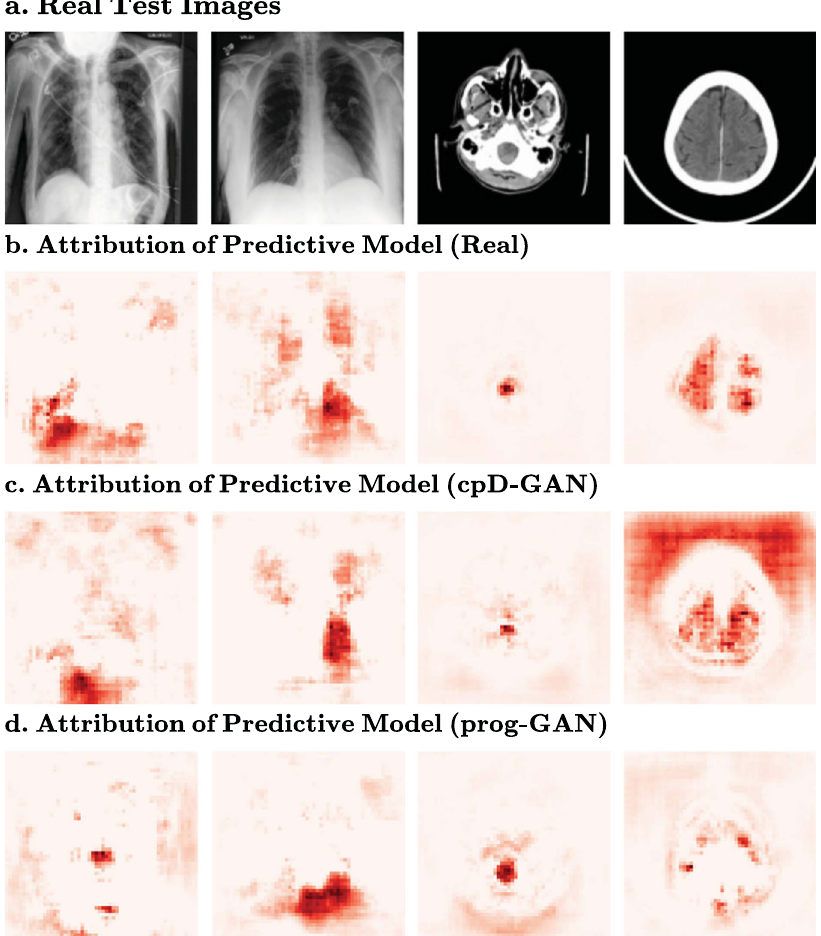
Fig. 7 Feature importance of predictive models trained on cpD-GAN and prog-GAN synthetics. Deeper red colour indicates regions that have a larger causal contribution to the label prediction. a Nearest neighbours from Supplementary Figs. 3 and 4 at 128 × 128 resolution. From left to right: (1) Chest X-ray with support device, lung opacity, pneumonia and atelectasis. (2) Chest X-ray with cardiomegaly and oedema. (3) Brain scan with subarachnoid haemorrhage. (4) Brain scan with subdural haemorrhage. b Feature importance of predictive model trained on real data. c Feature importance of predictive model trained on synthetic data generated by the cpD-GAN. d Feature importance of predictive model trained on synthetic data generated by the